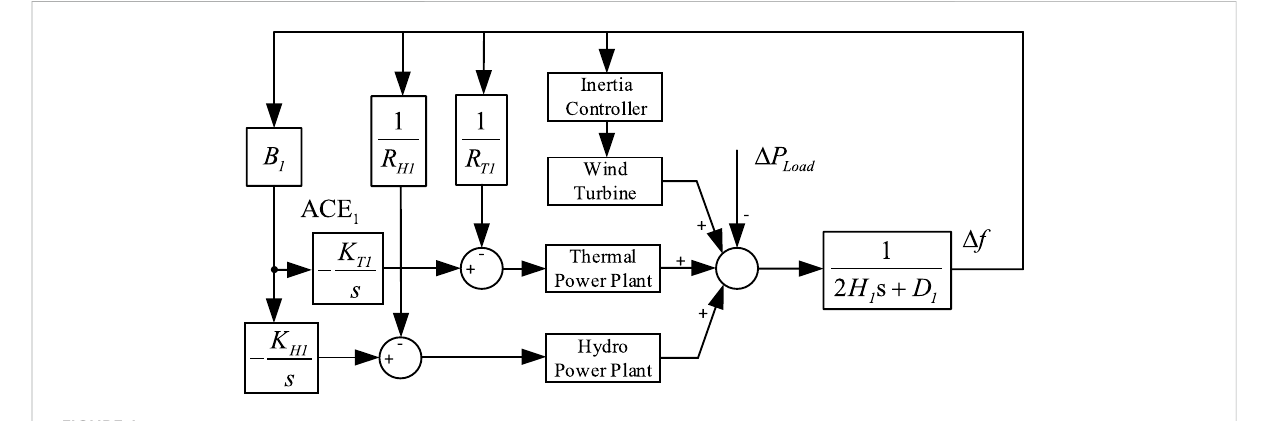
FIGURE 1 Frequency regulation model of the power system with the WT.